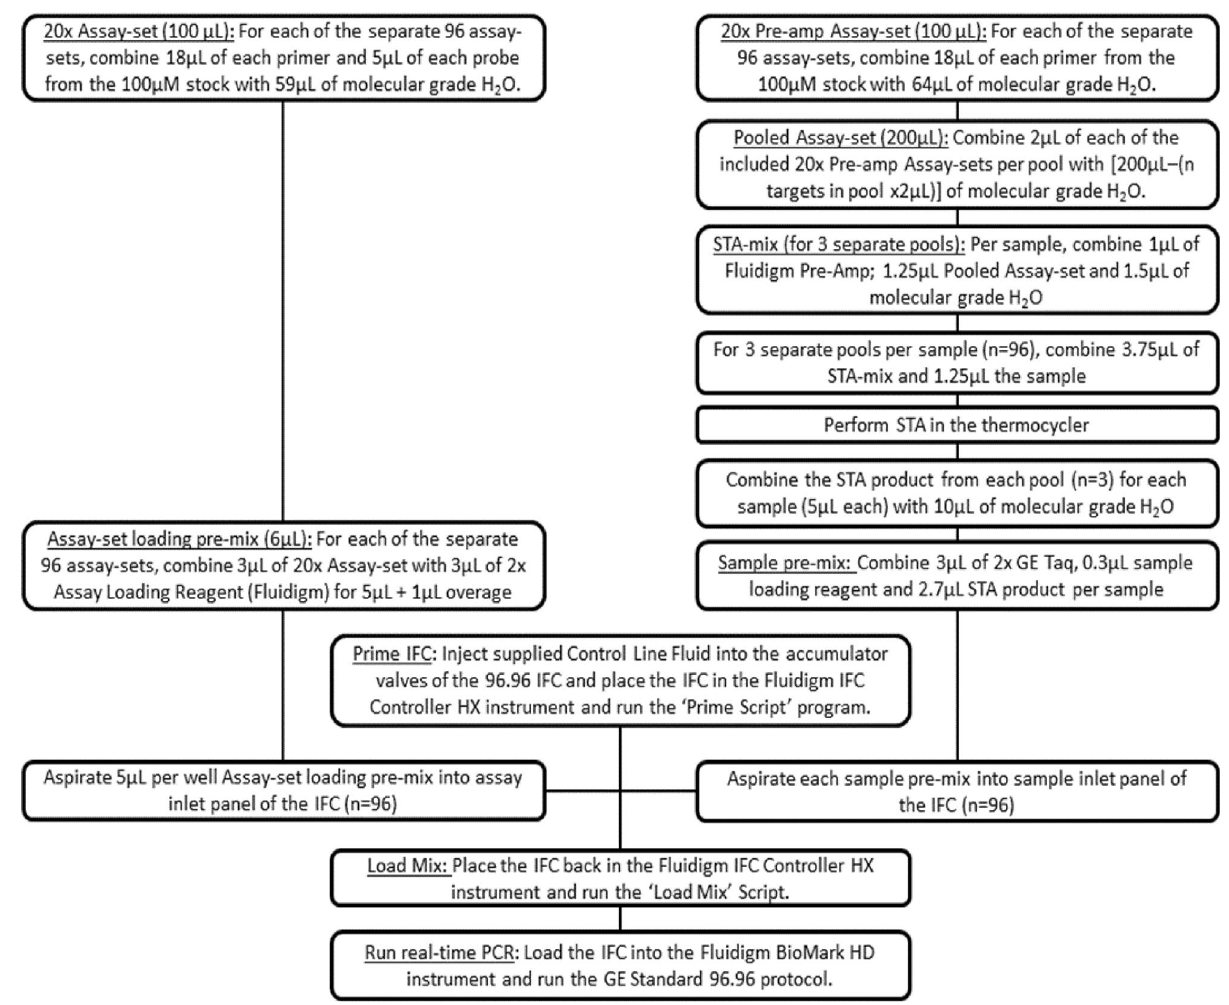
Figure 3. Flow diagram of the Specific Target Amplification (STA) within single 0.6 mL PCR tubes in the Bio-Rad T100 Thermal Cycler and the nano-fluidic high throughput real-time PCR within the 96.96